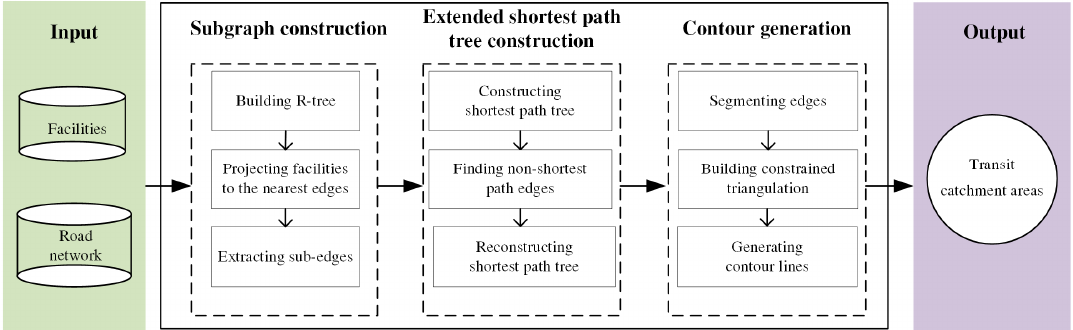
Figure 1. Framework of generating the network-based transit catchment areas by walking.